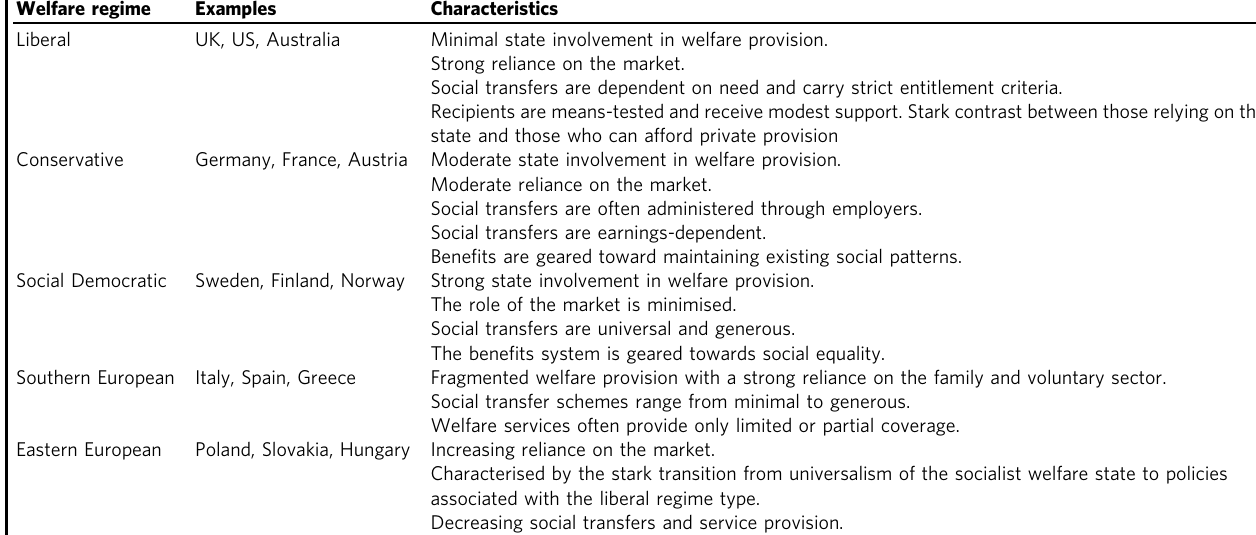
Table 1 Welfare regime and their characteristics (Ekimo and Bambra,